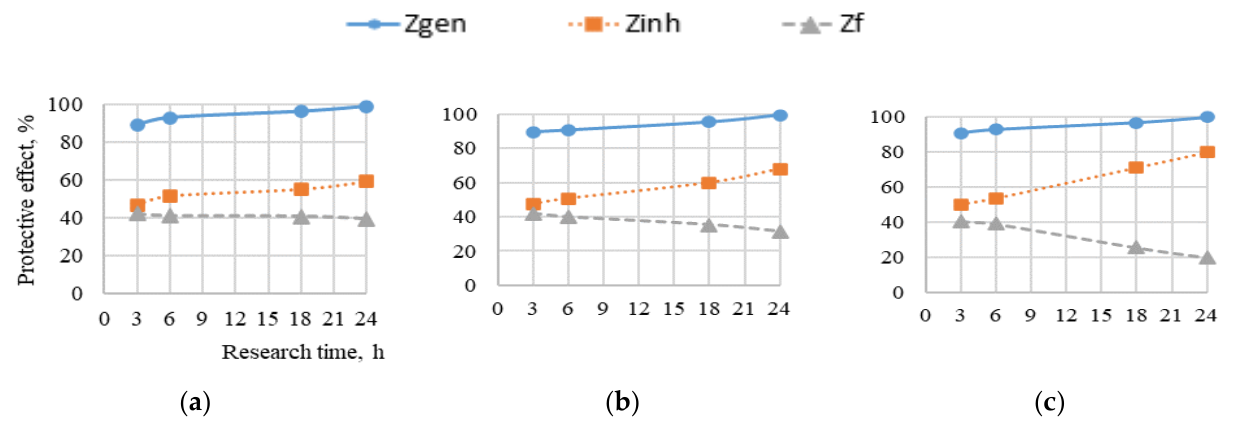
Figure 8. The protective effect of the IC-2 inhibitor at conc. 0.4% wt. in sulfamic acid 5% wt. ( a ), 10% wt. ( b ), and 15% wt. ( c ). 10% wt. ( b ), and 15% wt. ( c ).